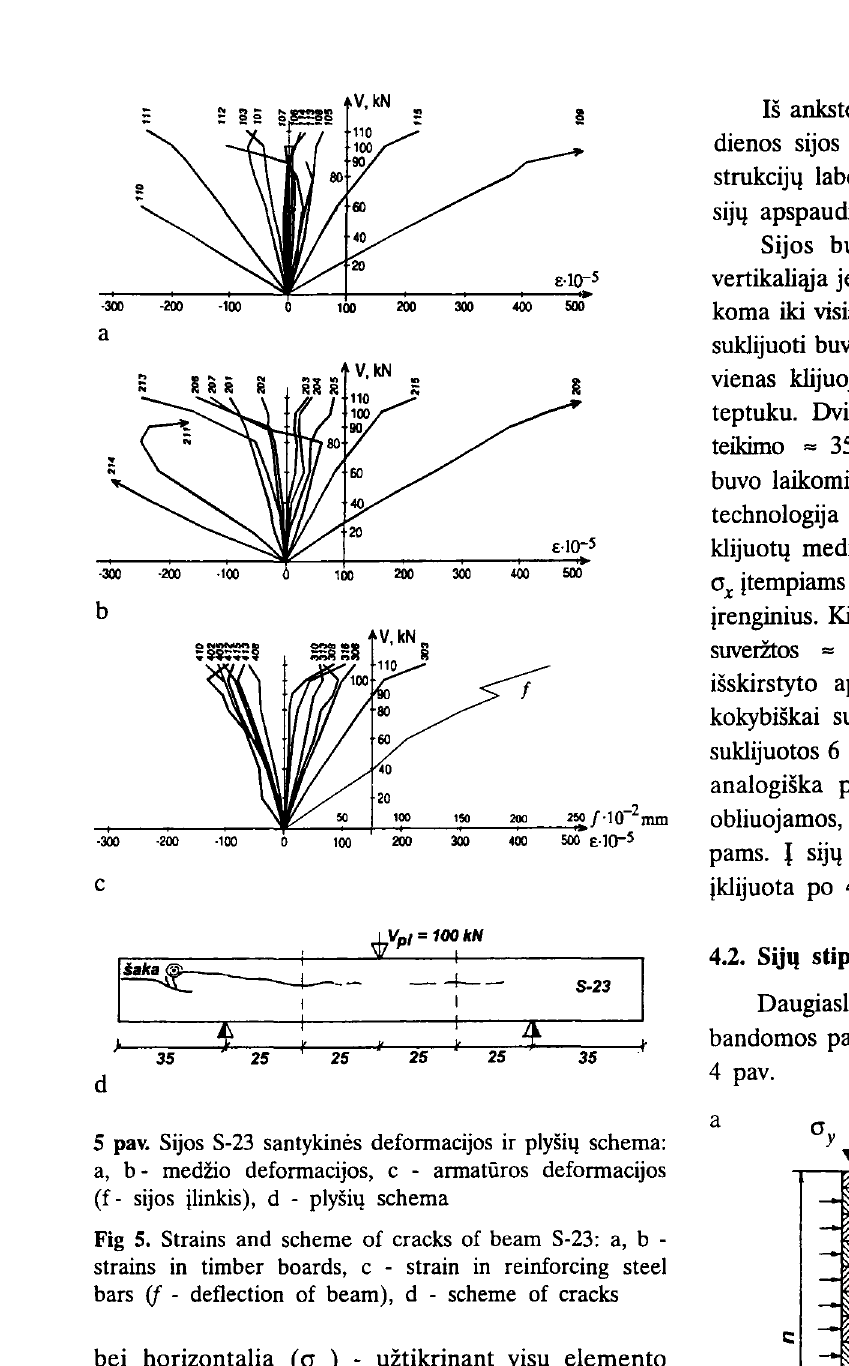
5 pav. Sijos S-23 santykines deformacijos ir plysiq schema: a, b - medzio deformacijos, c - armaturos deformacijos (f- sijos jlinkis), d - plysiq schema Fig 5. Strains and scheme of cracks of beam S-23: a, b - strains in timber boards, c - strain in reinforcing steel bars (f - deflection of beam), d - scheme of cracks bei horizontalia (ax ) - uztikrinant viSl! elemento sluoksnil! suklijavim'l. 6 pav. parodyta principine daugiasluoksnio is anksto jtempto elemento gamybos schema, pateikta isradime Nr. 954237.